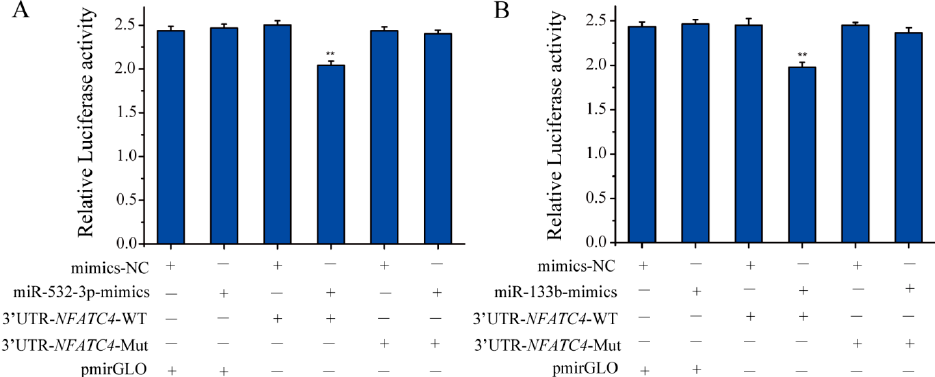
Figure 9. The repressive effect of miR-532-3p ( A ) and miR-133b ( B ) on the activity of NFATC4 3 ′ UTR